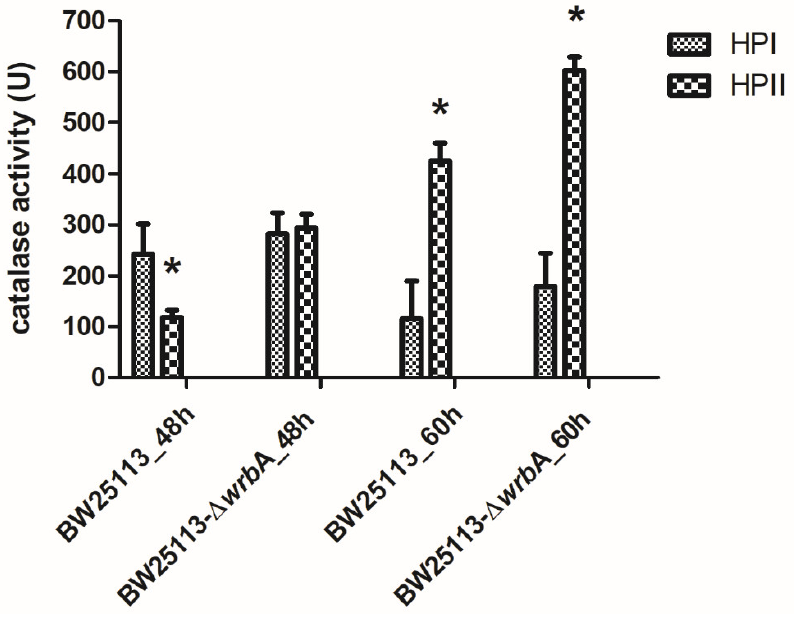
Figure 5. Catalase activities of both BW25113 and BW25113-∆ wrb A biofilms at 48 and 60 h, shown as the mean values of catalase activity (unit) with the standard deviation of three independent measurements. The asterisks indicate statistically significant differences (t-test, p ≤ 0.05) between the two strains.